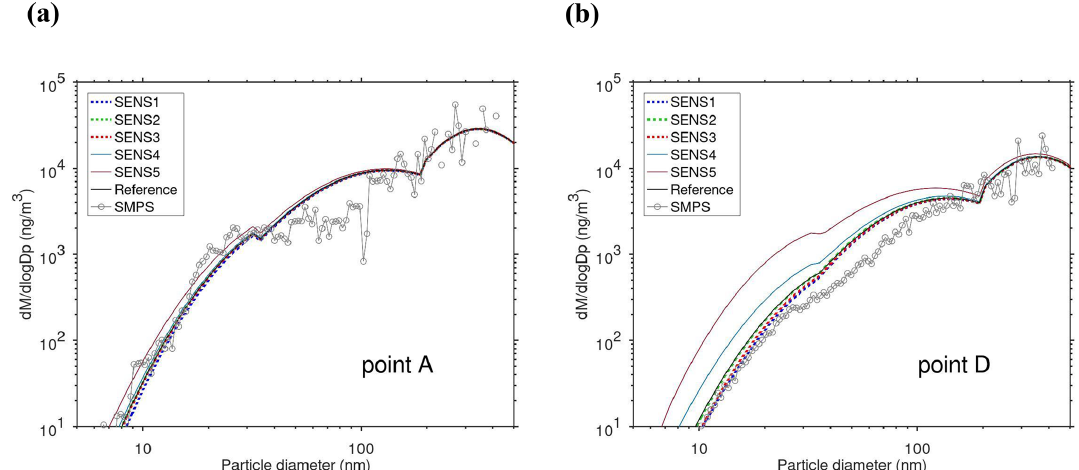
Figure G1. Comparison of particle mass size distribution for the diameter range 5–500nm in the Urban Case simulation. Plots show the modelled mass size distribution from the reference run (including all processes) and the five condensation sensitivity tests (SENS1 to SENS5) with MAFOR together with the observed mass size distribution derived from SMPS measurements using particle density of 1000kgm − 3 to convert from number to mass: (a) size distribution of the total mass at point A; (b) size distribution of the total mass at point D.